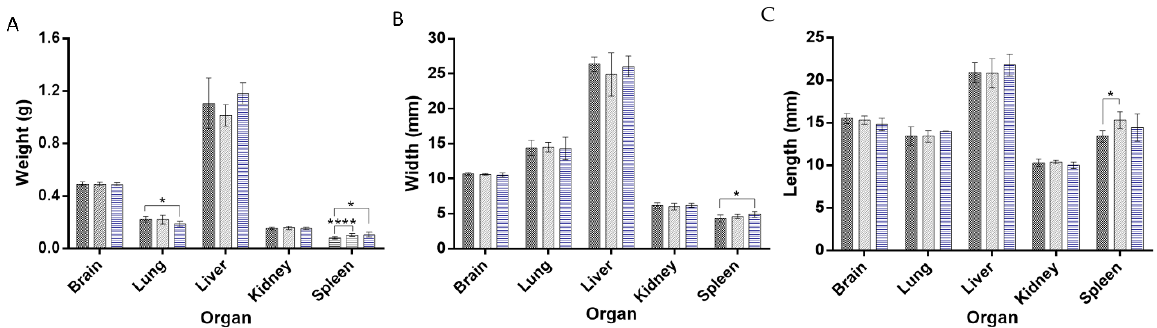
Figure 6. ( A ) Absolute organ weight, ( B ) organ width, and ( C ) organ length of mice treated with repeated doses of PBS (dark gray), neutral (light gray), and cationic (blue) liposomes. * p < 0.05, **** p < 0.0001.